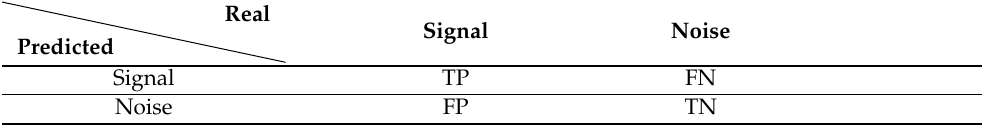
Table 2. Classification confusion